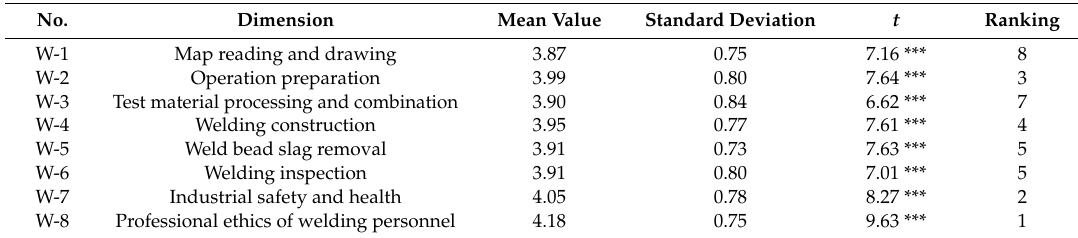
Table 8. Analysis of the demonstration of students’ welding ability.